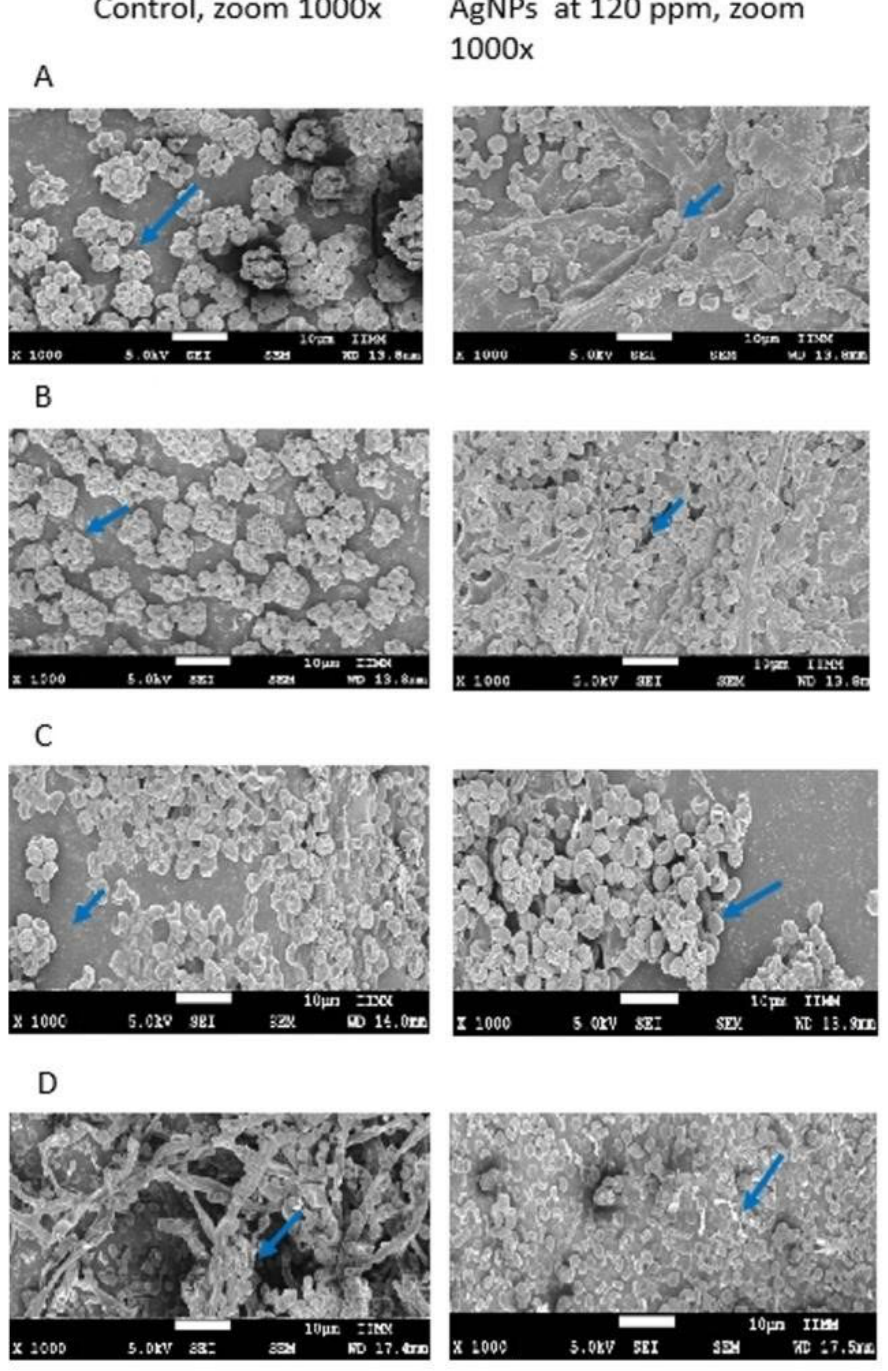
Figure 5. Spores and mycelia of beneficial fungi under the electron microscope at 1000×; ( A ) Trichoderma fasciculatum , ( B ) T. viridae , ( C ) Metarhizium anisopliae and ( D ) Beauveria bassiana . The arrow mark in the image indicates the injury in the fungi